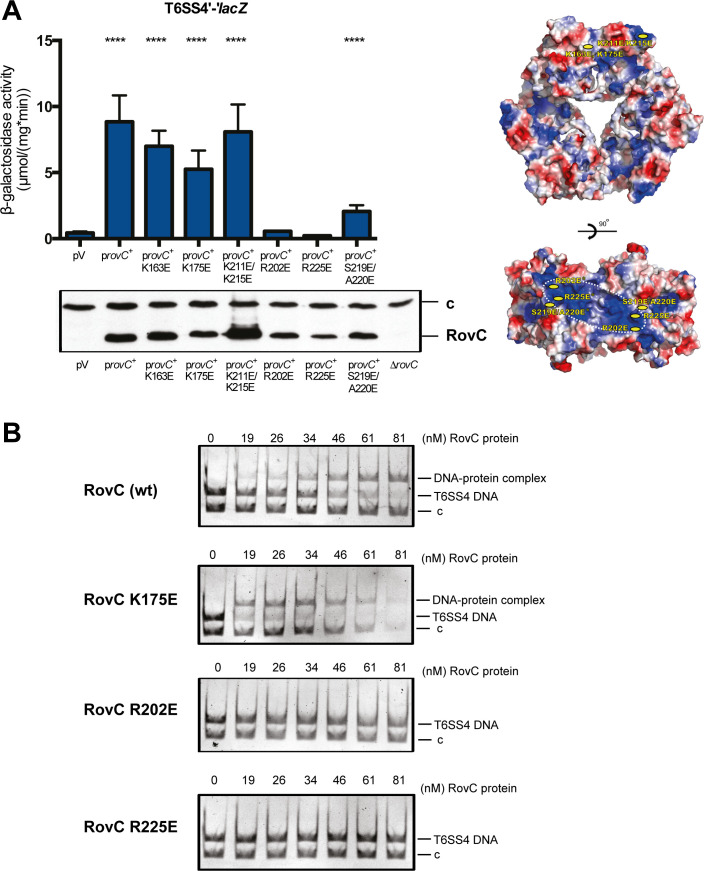
DNA-binding of RovC is required for induction of the T6SS4 operon.(A) Expression of a translational T6SS4’-‘lacZ reporter fusion (pSSE64) was measured in Y. pseudotuberculosis wild-type strain YPIII. YPIII was transformed with the empty vector pZA24 (pV) and complemented with the arabinose-inducible rovC+ overexpression plasmids pVK46 (provC+), pVK47 (provC+ K163E), pVK48 (provC+ K175E), pVK49 (provC+ K211E/K215E), pVK50 (provC+ R202E), pVK51 (provC+ R225E) and pVK52 (provC+ S219E/A220E). Strains were grown over night for 12 h at 25°C in LB medium. Expression of the Para promoter was induced by addition of 0.1% arabinose and β-galactosidase activity (μmol/mg.min) was measured after 4 h (left upper panel). The data represent the mean ± standard deviation of two independent experiments, carried out in triplicates. Data were analyzed by the Student’s t-test; **** P < 0.0001, *** P < 0.001; n.s.: not significant) (top). Western blot to monitor the amount of synthesized RovC protein. Whole cell extracts were prepared from overnight cultures grown for 16 h at 25°C in LB medium, separated on 15% SDS gels and transferred onto a PVDF membrane. Proteins were detected by immunoblotting with a polyclonal antibody directed against RovC. An unspecifically detected protein band was used as loading control (c) and the ΔrovC mutant strain served as negative control (left lower panel). Electropotential surface analysis of RovC hexamer is shown on the right (right panel) in two orientations. Potentials between -69.553 kT/e (red) and + 69.553 kT/e (blue) are color-coded. The positions of mutants used in the in vivo induction analysis (A, left panel) and in vitro DNA-binding analysis by EMSA (B) are marked. (B) EMSAs with purified wild-type and different mutant variants (RovC K175E, RovC R202E and RovC R225E). 130 fmol of DNA were incubated with increasing amounts of the different hexameric RovC proteins (0–81 nM) for 30 min at room temperature. A csiD DNA fragment (c) from E. coli was used as negative control.